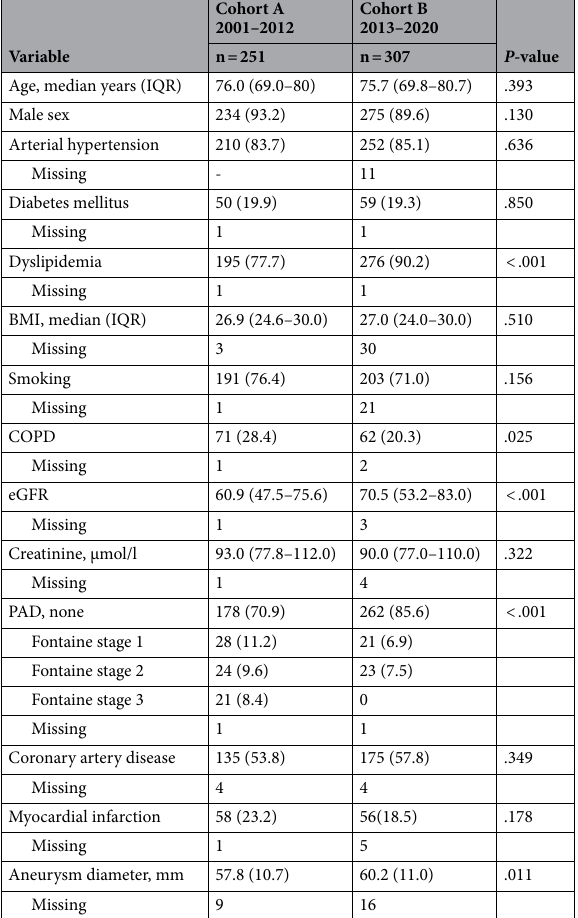
Table 1. Baseline Characteristics. Data was complete if not stated explicitly. Continuous variables are presented by the mean and (standard deviation) if normally distributed of by median and (interquartile) range if skewed. Counts are presented with number and (percentage). BMI body mass index, COPD chronic obstructive pulmonary disease, eGFR estimated glomerular filtration rate according to the “Modification of Diet in Renal Disease Study” (MDRD) equation presented as mean ml/min/1.73 m 2 and (standard deviation), PAD peripheral arterial disease as clinical stage according to the Fontaine classification. Factor variables were compared by chi2 test, continuous variables by Student’s t-test if normally distributed or by the Kruskal–Wallis rank test if skewed, respectively.